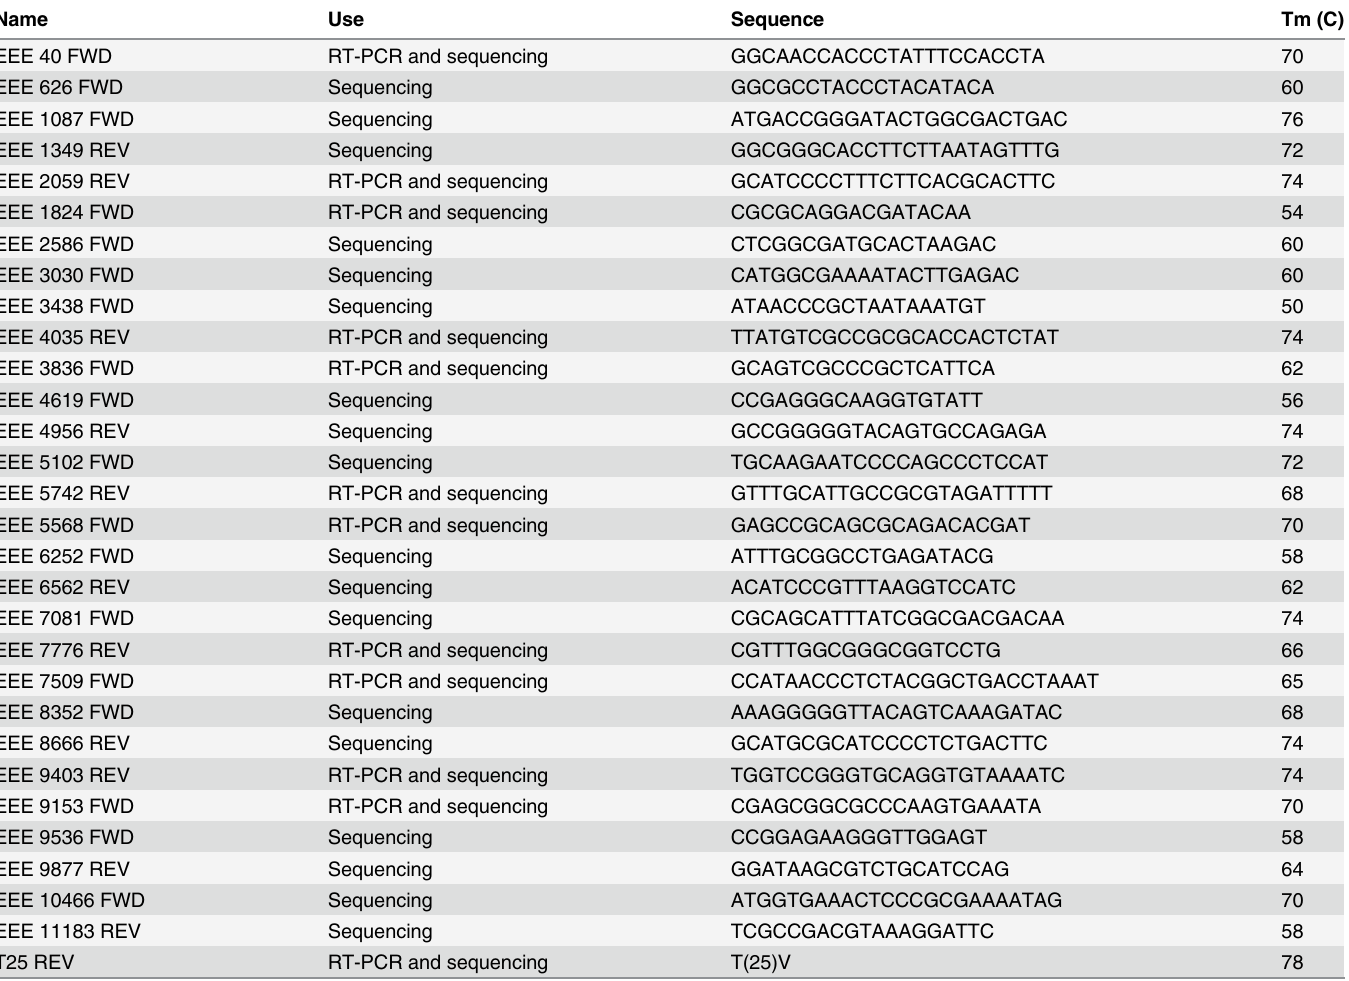
Table 1. The oligonucleotides used for EEEV full genome